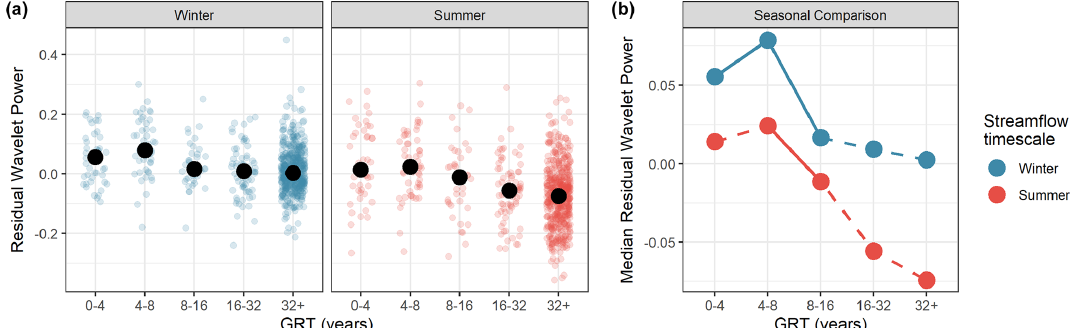
Figure 7. As in Fig. 6 but for the groundwater response times